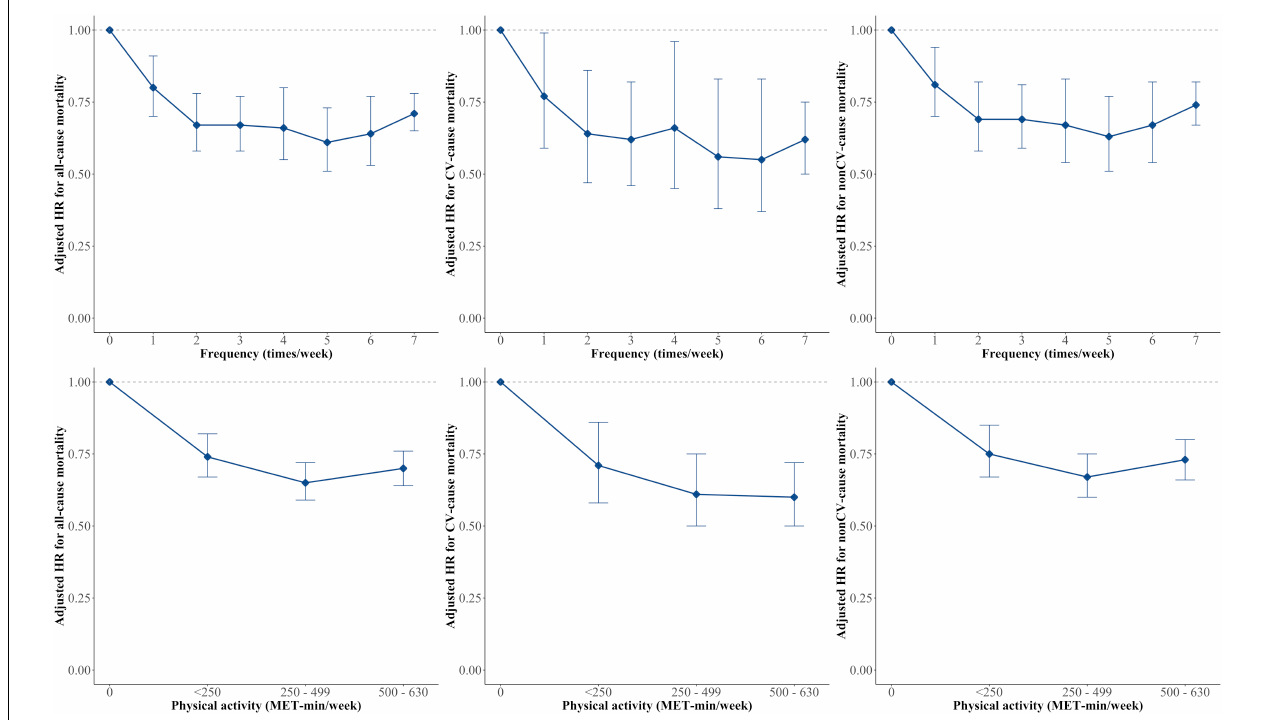
FIGURE 2 | Hazard ratios (HRs) of All-cause, CV, and non-CV-mortality by exercise frequency, and physical activity level in those who did not perform any activity beyond LPA. Multivariable Cox regression models were constructed with adjustment for age, sex, income level, residential area (urban or non-urban), body mass index, hypertension, diabetes mellitus, dyslipidemia, smoking, alcohol intake, chronic kidney disease, chronic obstructive lung disease, liver disease, malignancy, cardiovascular medications (aspirin, P 2 Y 12 inhibitor, statin, anticoagulant, beta-blocker, angiotensin converting enzyme inhibitor or angiotensin receptor blocker, calcium channel blocker, digoxin, diuretics) and Charlson comorbidity index. CV, cardiovascular; MPA, moderate-intensity physical activity; MET, metabolic equivalent of